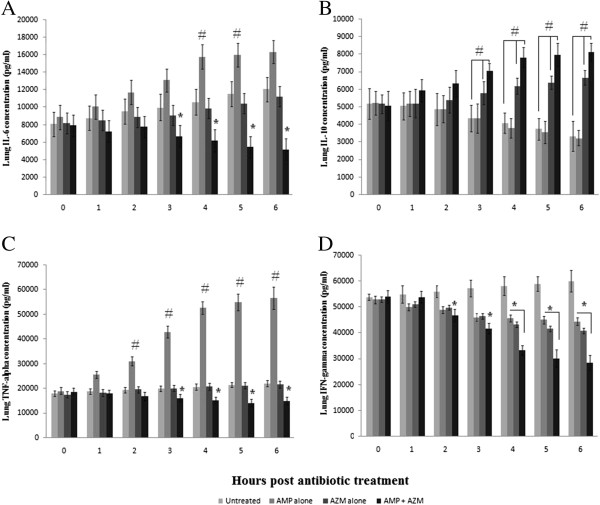
Cytokine level in lung tissue. Groups of mice (n = 21) were infected with AMRI-SP1 and were monitored for the development of pneumonia. 18 h post infection treatment with either AMP at 200 mg/kg or AZM at 50 mg/kg body weight, single dose of antibiotic treatment was initiated. Considering 18th h to be the zero hour of antibiotic treatment, animals were sacrificed every hour continuing till 24th h post infection (i.e. 6th hour post antibiotic treatment). After administration of the single antibiotic dose, lungs were homogenized and assayed for estimation of cytokines. Levels of IL-6 (A); IL-10 (B); TNF-α (C) and IFN-γ (D) were determined and mean ± SD of values obtained were expressed in pg/ml from triplicate experiments. Untreated, S. pneumoniae infected; AMP, S. pneumoniae infected and treated with ampicillin; AZM, S. pneumoniae infected and treated with azithromycin; Combined, S .pneumoniae infected and treated with both ampicillin and azithromycin. #, Significant increase or *, Significant decrease in combined treatment group compared to monotherapy with AMP or AZM alone at P < 0.05.